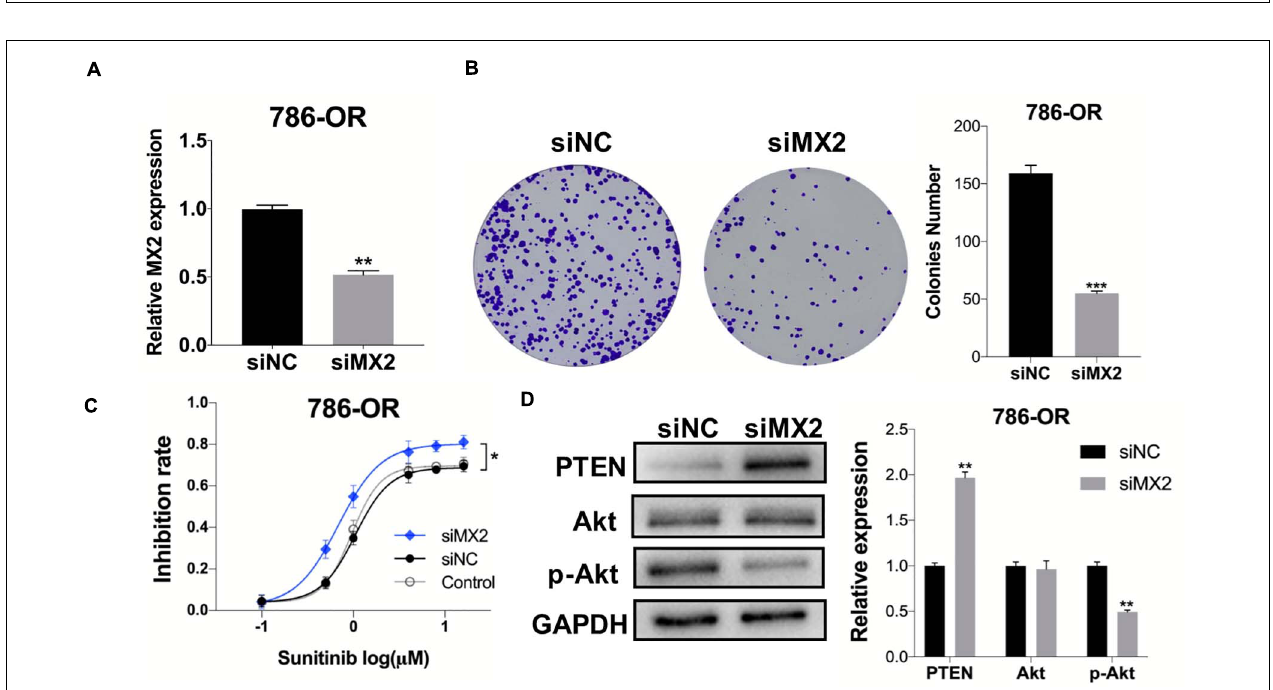
FIGURE 8 | MX2 knockdown sensitized cells to sunitinib through PTEN/Akt signaling. (A) Relative MX2 mRNA expression in 786-OR cells after being transfected with siRNA. (B) Results of colony formation assay of 786-OR after being transfected with siRNA. (C) Result of inhibition rate assay on 786-OR cells after transfected with siRNA. (D) Relative protein level of PTEN, Akt and p-Akt in 786-OR cells after transfected with siRNA. The error bars represent mean ± SD. Data differences were tested with Student’s t -test (* p < 0.05; ** p < 0.01; *** p < 0.001).